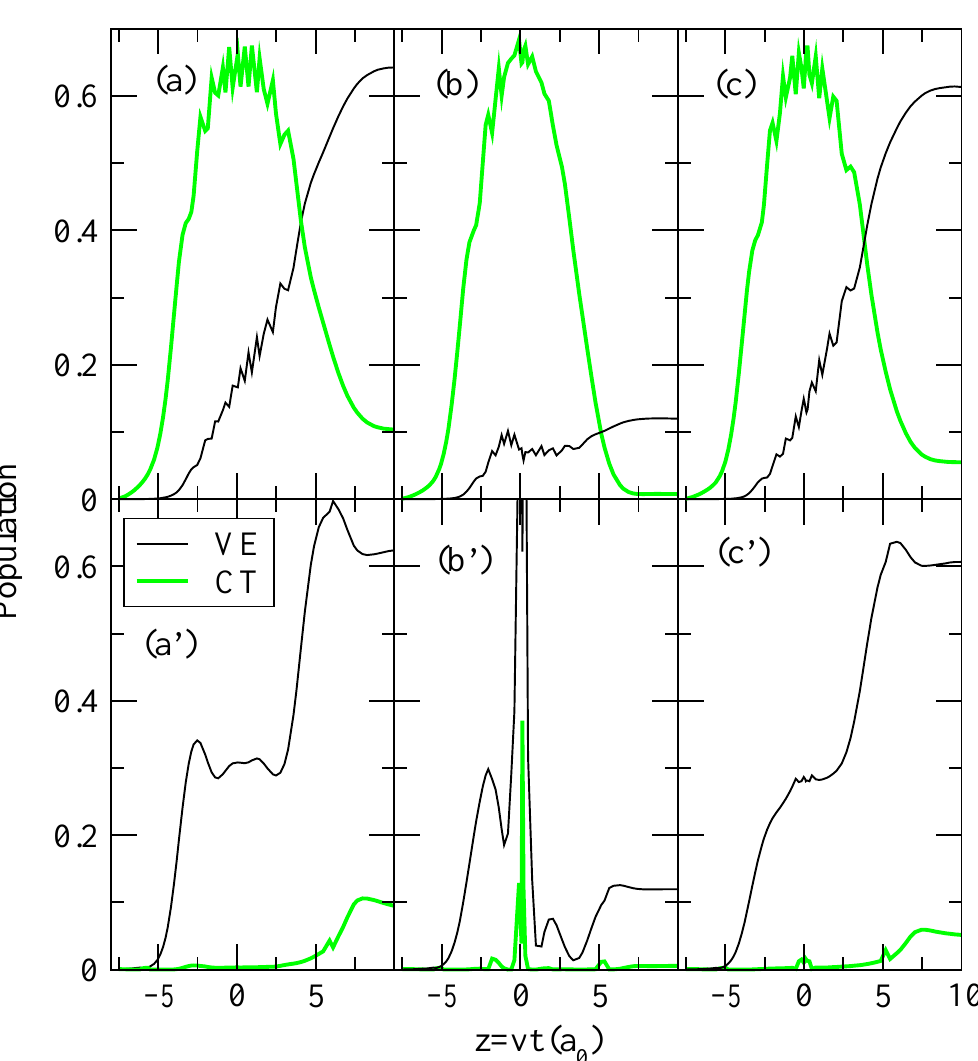
Figure 6: Collision histories of vibrational excitation (VE) and charge transfer (CT) channels for trajectories I (a,a’), II (b,b’) and III (c,c’). Collision energy is E = 62 . 5 eV and impact parameter b = 1 . 75 a . Panels (a,b,c) contains results in the diabatic basis, while panels (a’,b’,c’) are in the 0 adiabatic